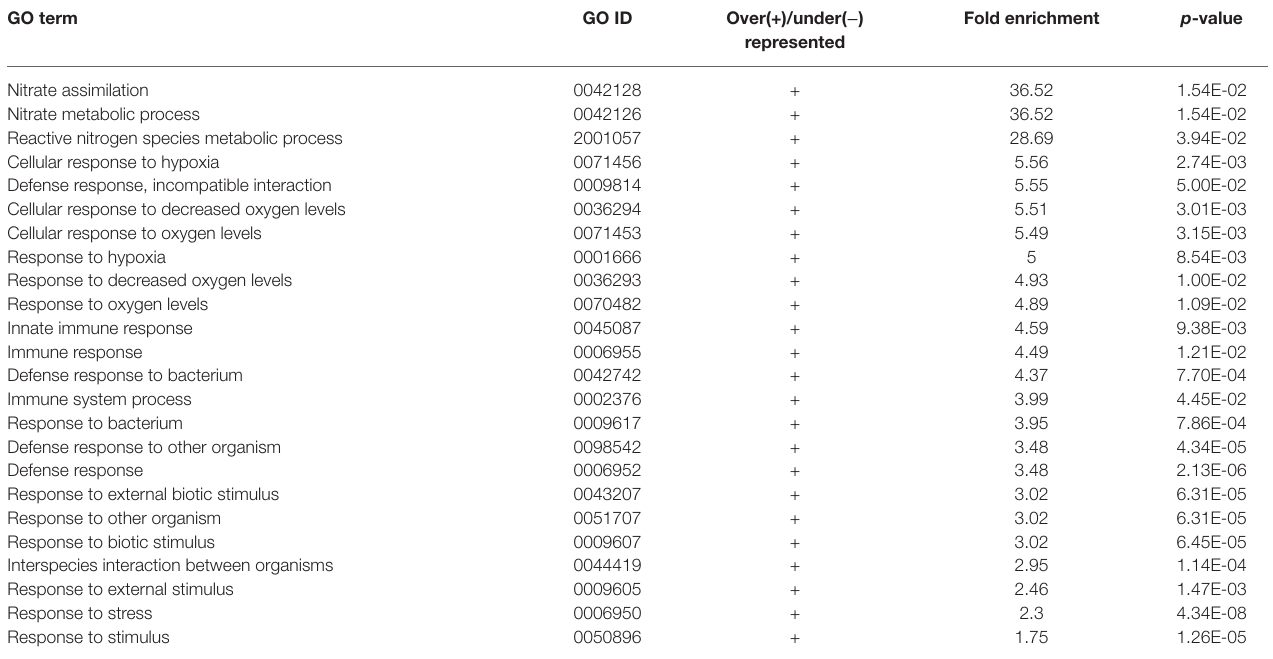
TABLE 2 | Enrichment of GO terms related to molecular functions of differentially expressed genes between gntI and wild-type seedling roots. GO term GO ID Over(+)/under( − ) Manganese ion